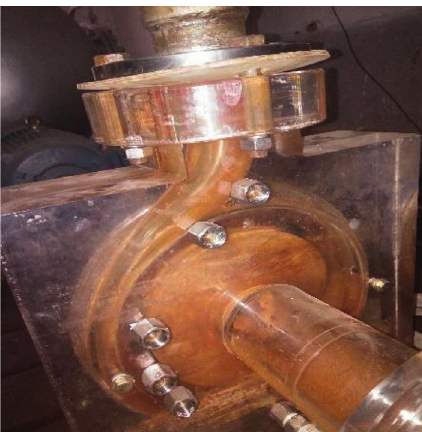
Figure 1: Experimental model of the centrifugal pump.